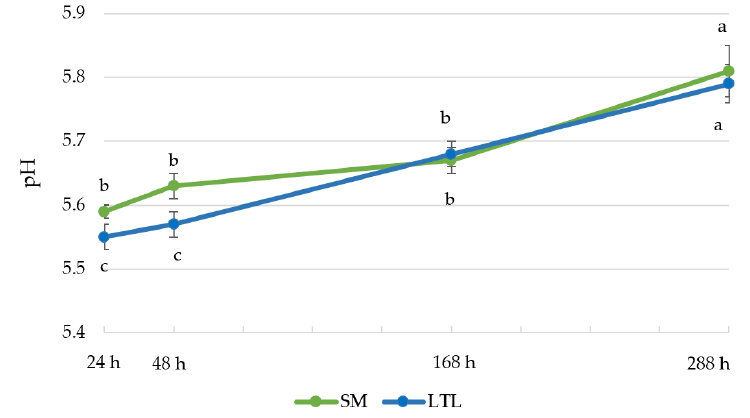
Figure 1. Changes in pH during ageing of semimembranosus (SM) and longissimus thoracis et lumborum (LTL) fallow deer muscles. a–c—mean values with different letters differ significantly at p < 0.05.